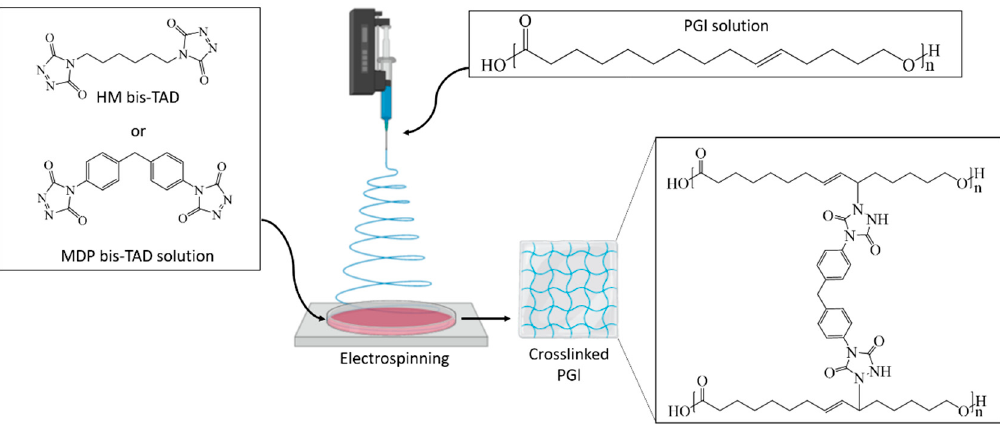
Figure 2. Electrospinning of PGl fibres directly into a bisTAD containing collector solution; note that only the MDP-bisTAD crosslinked product is depicted.